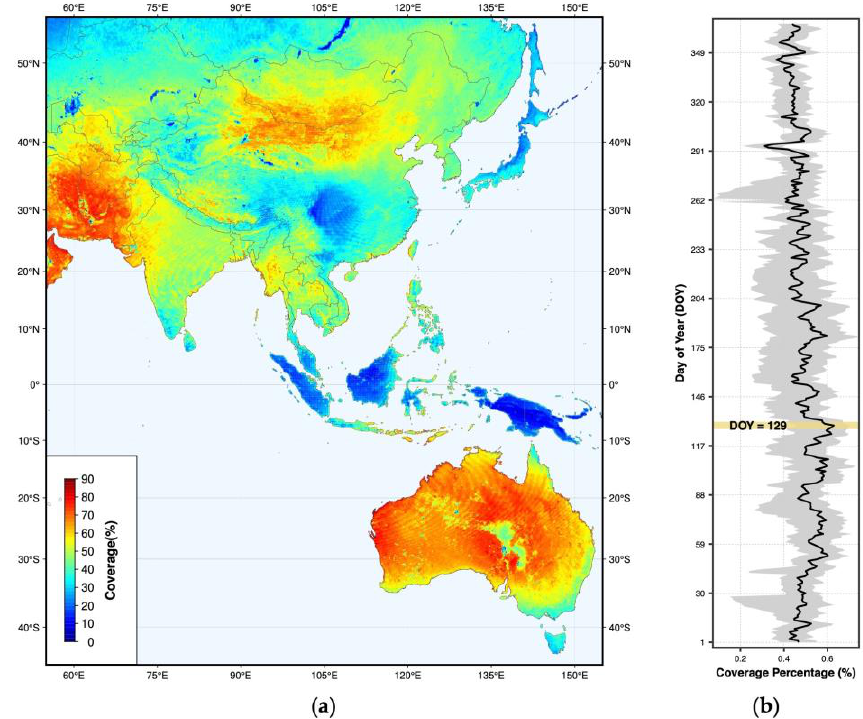
Figure 8. Spatial coverage of hourly maps of SAT estimated using the STRF model: ( a ) annual coverage percentage on a pixel-by-pixel basis; ( b ) daily mean coverage percentage of the estimated maps at 24 h points of a day (denoted by the black line) with the gray ribbon indicating the lowest and highest coverage of the 24 maps of hourly SAT.